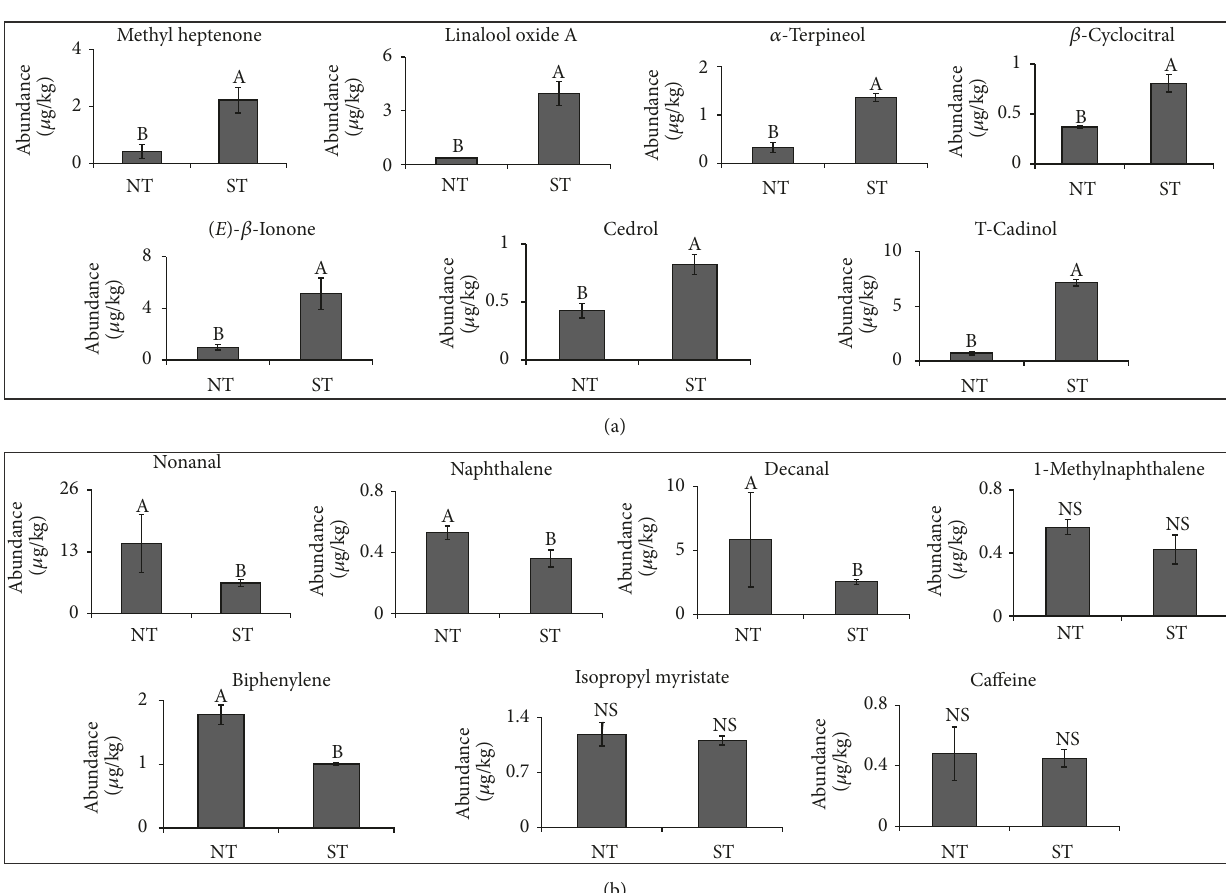
Figure 5: Volatiles with differential abundances between scented and nonscented teas but undetectable in the jasmine flower headspace. (a) Enhanced volatiles in the scented tea; (b) reduced volatiles in the scented tea. ST: scented green tea infusion; NT: nonscented tea infusion; ND: not detected. Duncan’s new multiple range test was performed and the columns labeled with the same letter within the same compound had no significant difference among the three samples, 𝑃 < 0.05 . NS: no significant difference